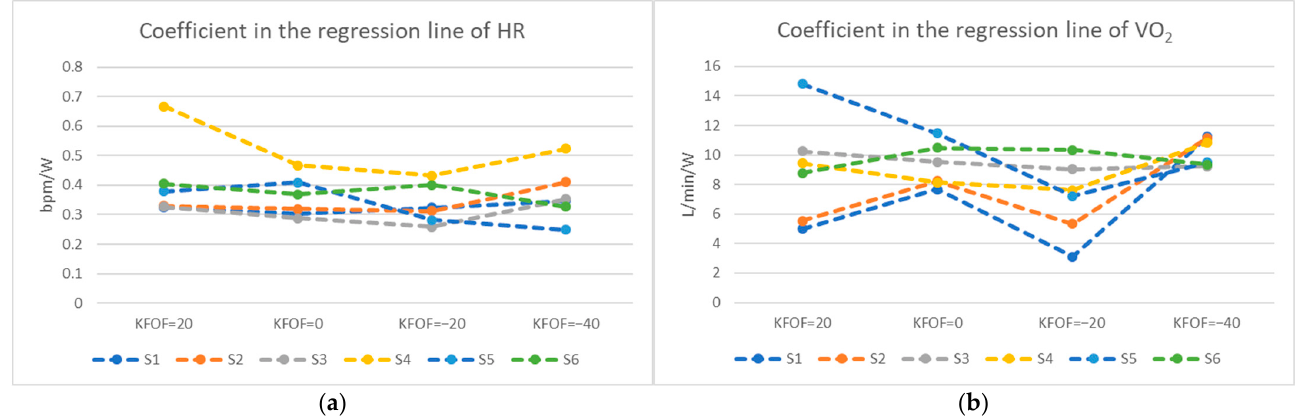
Figure 4. Coefficient in the regression line of ( a ) heart rate (HR); ( b ) oxygen consumption (VO 2 ).